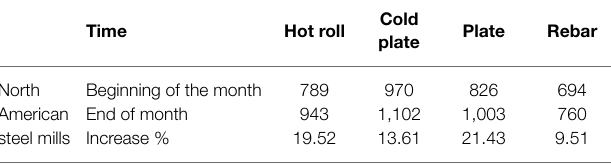
TABLE 3 | North American market steel price list in